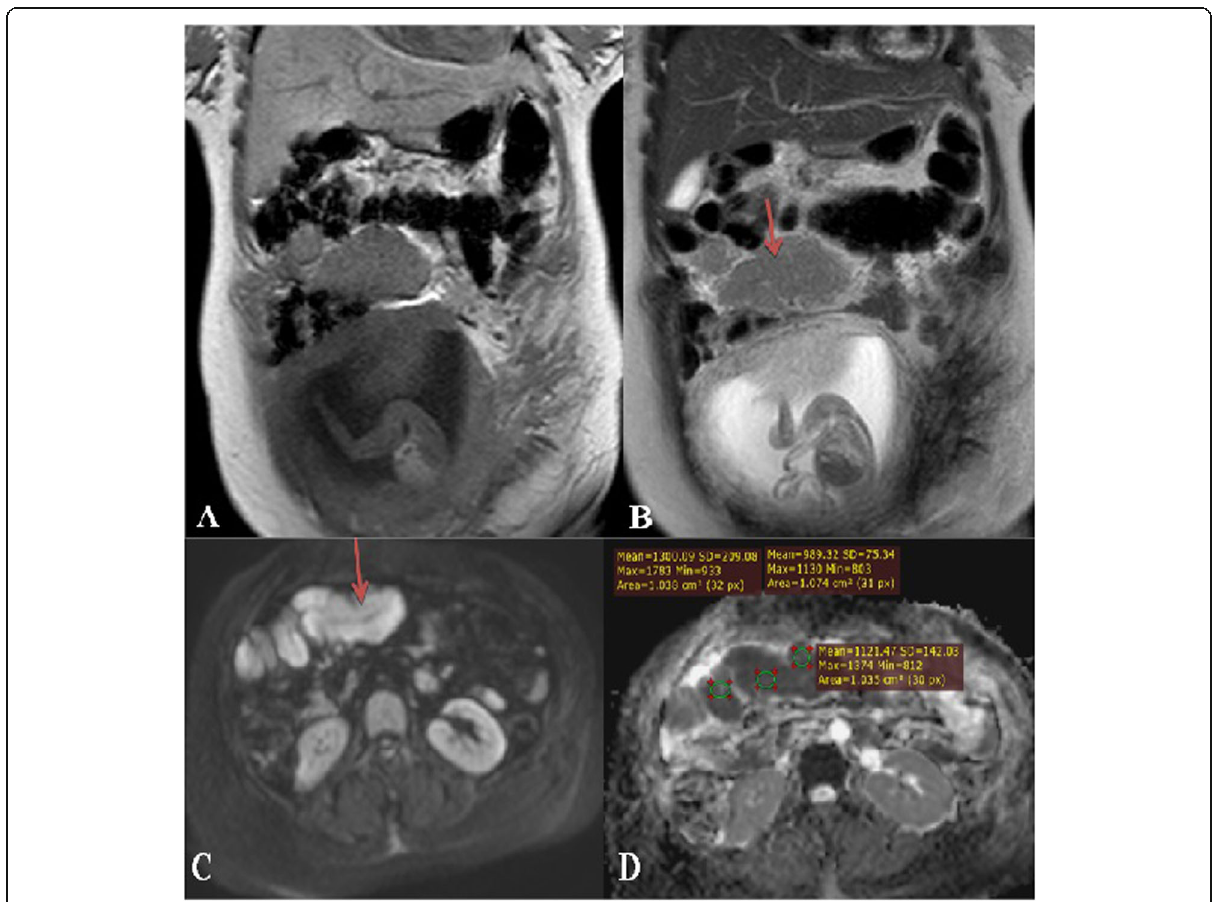
Fig. 1 Forty-twoyear old male patient with diffuse abdominal pain and fever. a DWI at b 0. b DWI at b 500. c DWI at b 1000. d ADC map. Images showed diffuse sheets like pelvic peritoneal thickening (arrow) with high signal in DWI and low in ADC, impressive of restricted diffusion with average ADC value 0.86 ± 0.1 × 10 − 3 mm 2 /s. Exploration was done and final diagnosis with peritonitis secondary to acute